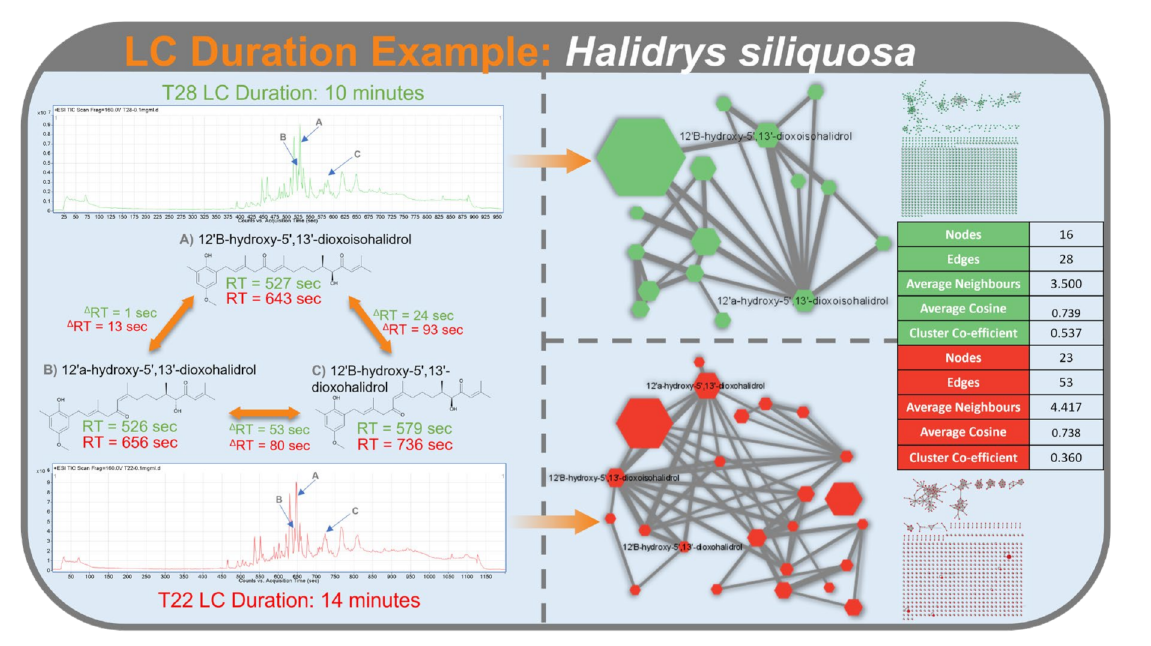
Figure 12. LC-MS 2 trace of Halidrys siliquosa using a LC duration of 10 min (top; green) and 14 min (bottom; red) with the retention times of the meroterpenoids under both conditions displayed. Cluster statistics for the meroterpenoid clusters for both LC-MS 2 runs are displayed on the